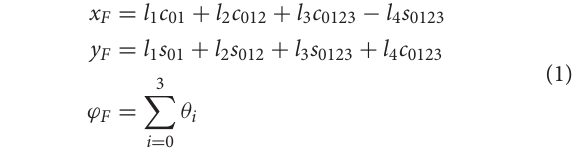
joints were considered as one DoF hinge joints. The angle θ 0 denotes the initial angle of the MCP joint. The abduction and adduction of the fingers were assumed to be zero. Further, all joints axes were assumed to be parallel to ˆ z MCP , which constrains the finger movements to be within the xy -plane ( Figure 3 ). The finger tip angle w.r.t. to the metacarpal bone is denoted as ϕ F